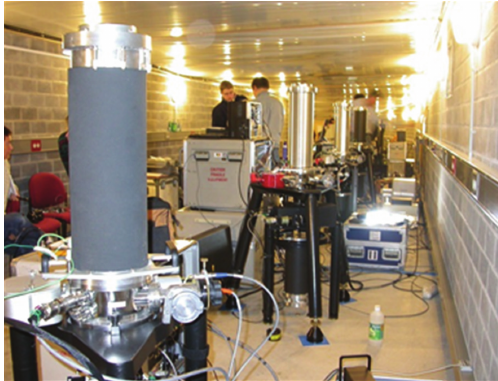
Figure 8: Impressive image of absolute gravimeters in “a raw” at